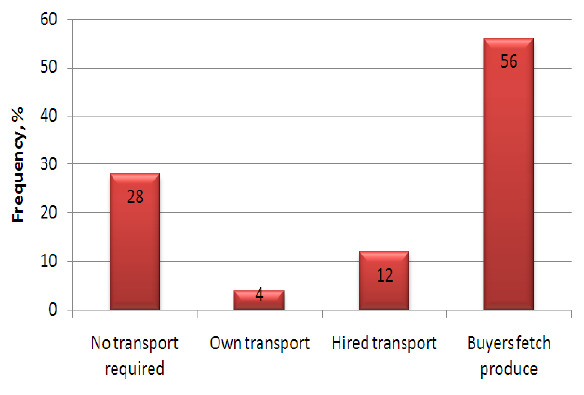
Fig. 7. Transportation of farm produce